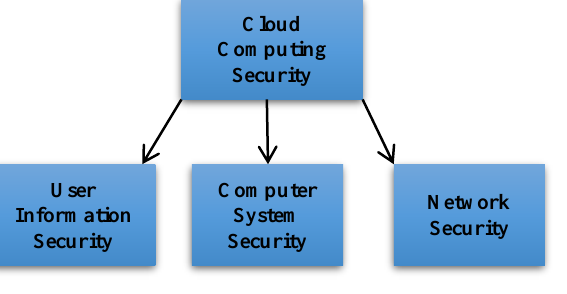
Figure 1. Categorical division of cloud computing